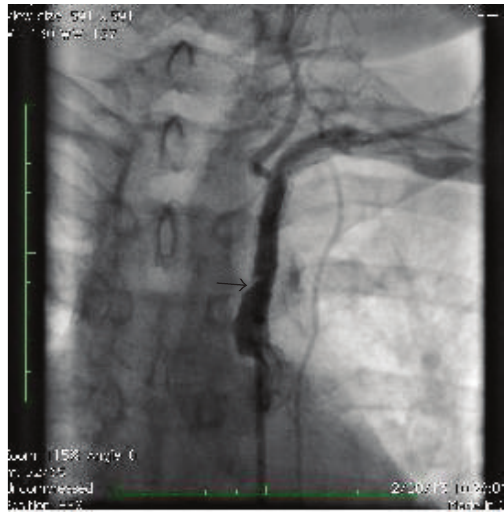
Figure 5: Angiogram showing mobile fractured in-stent stenosis in systole.